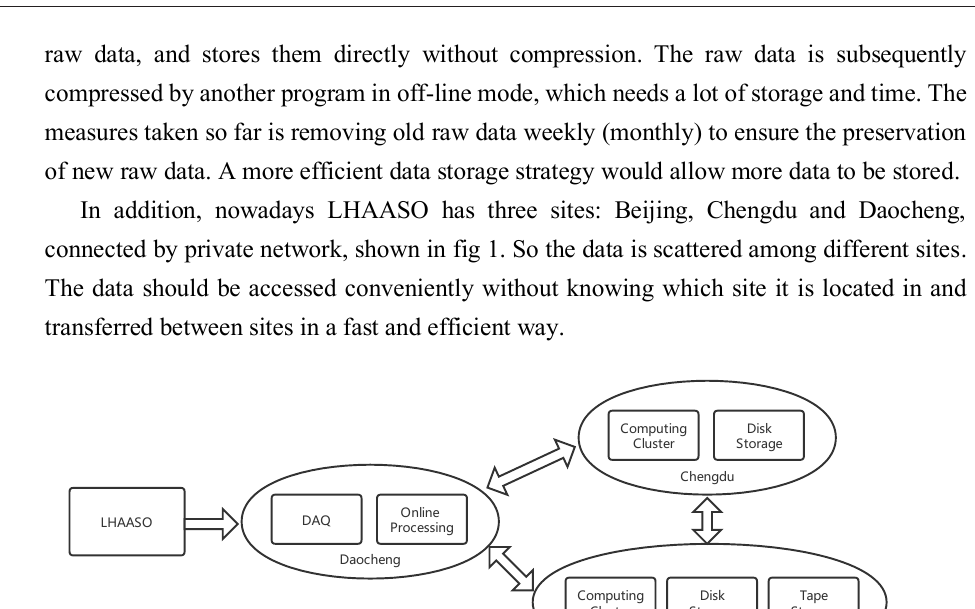
Fig. 1. Distributed sites in